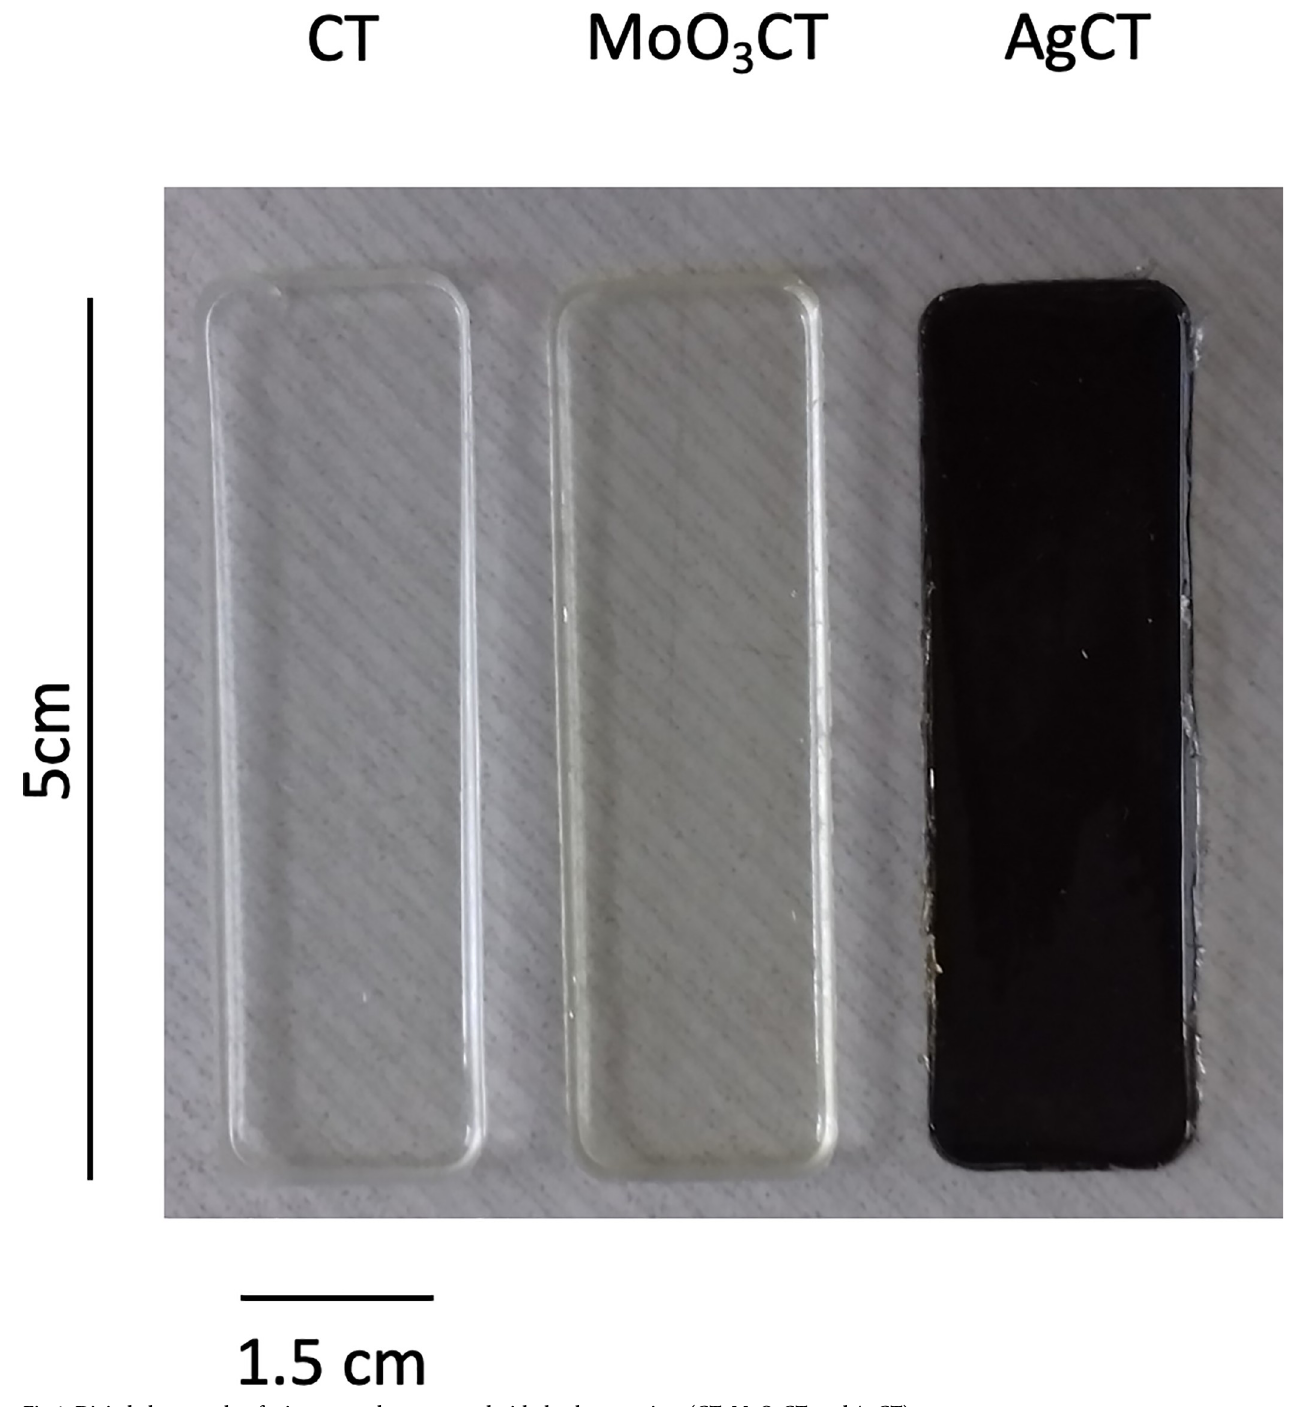
Fig 4. Digital photographs of microscope glasses covered with the three coatings (CT, MoO 3 CT, and AgCT).